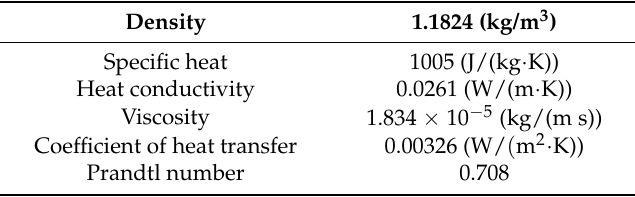
Table 3. Air flow physical parameters.